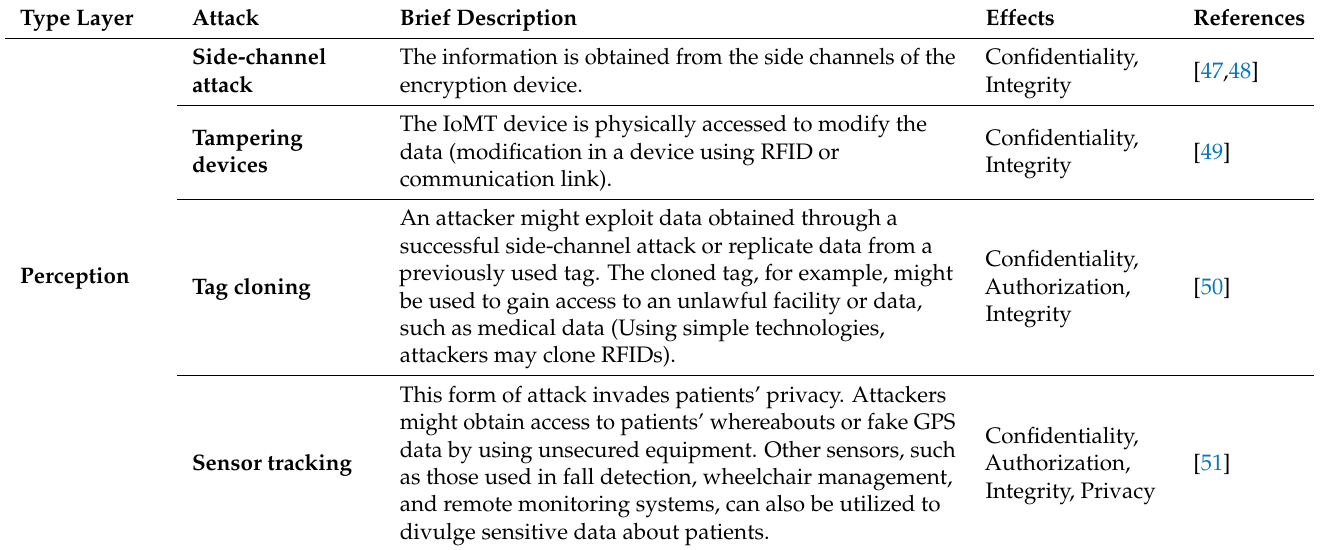
Table 3. IoMT potential attacks for each layer and their influence on the system’s security